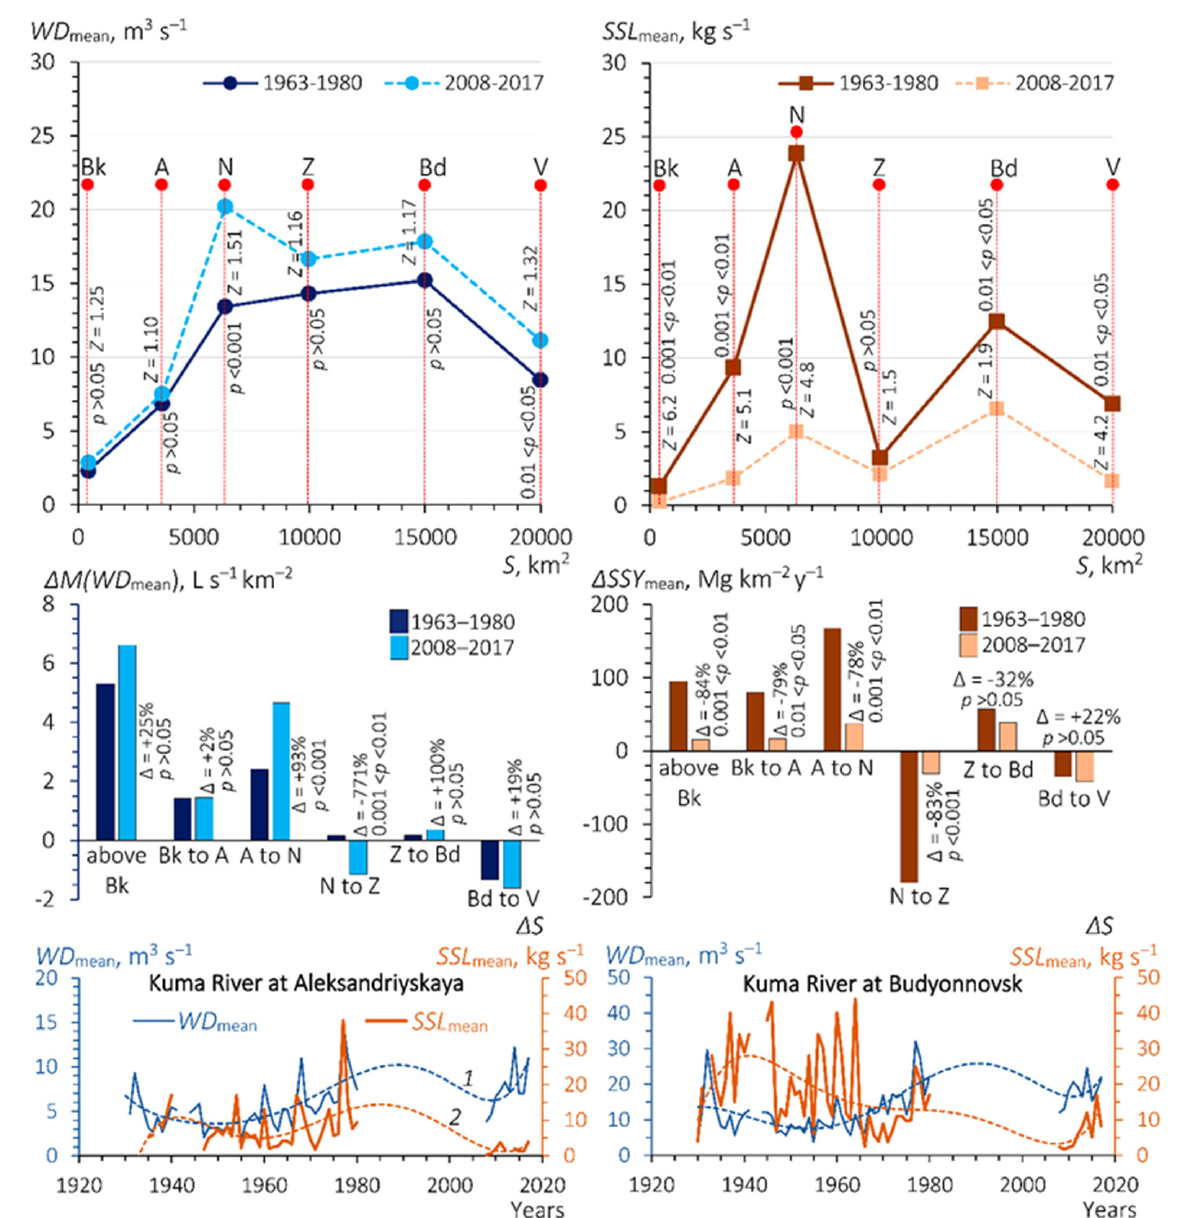
Figure 10. Changes in mean annual water discharge ( WD mean ) and mean annual suspended sediment load ( SSL mean ) along the Kuma River (a western tributary of the Caspian Sea, SW Russia) between 1963–1980 and 2008–2017. ∆ M ( WD mean ) and ∆ SSY mean —differential specific water discharge and suspended sediment yield, respectively; S —river basin area; ∆ S —differential river basin area; the sixth-degree polynomial trend line: 1 —for WD mean , 2 —for SSL mean ; p —the prob- ability of statistically significant difference for the indicated averaged values between the periods (the Student’s t -test); ∆ —relative changes; Z —absolute changes (times). Hydrological stations at (see Figure 1; Table 1) : Bk—Bekeshevskaya, A—Aleksandriyskaya, N—Novozavedennoye, Z—Zeleno- kumsk, Bd—Budyonnovsk, and V—Vladimirovka.